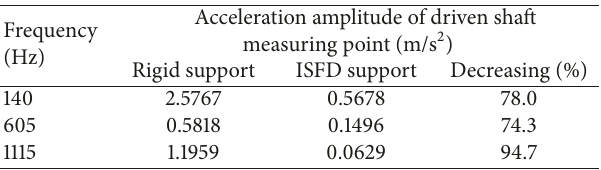
Table 3: Vibration reduction with different supports (driven shaft).